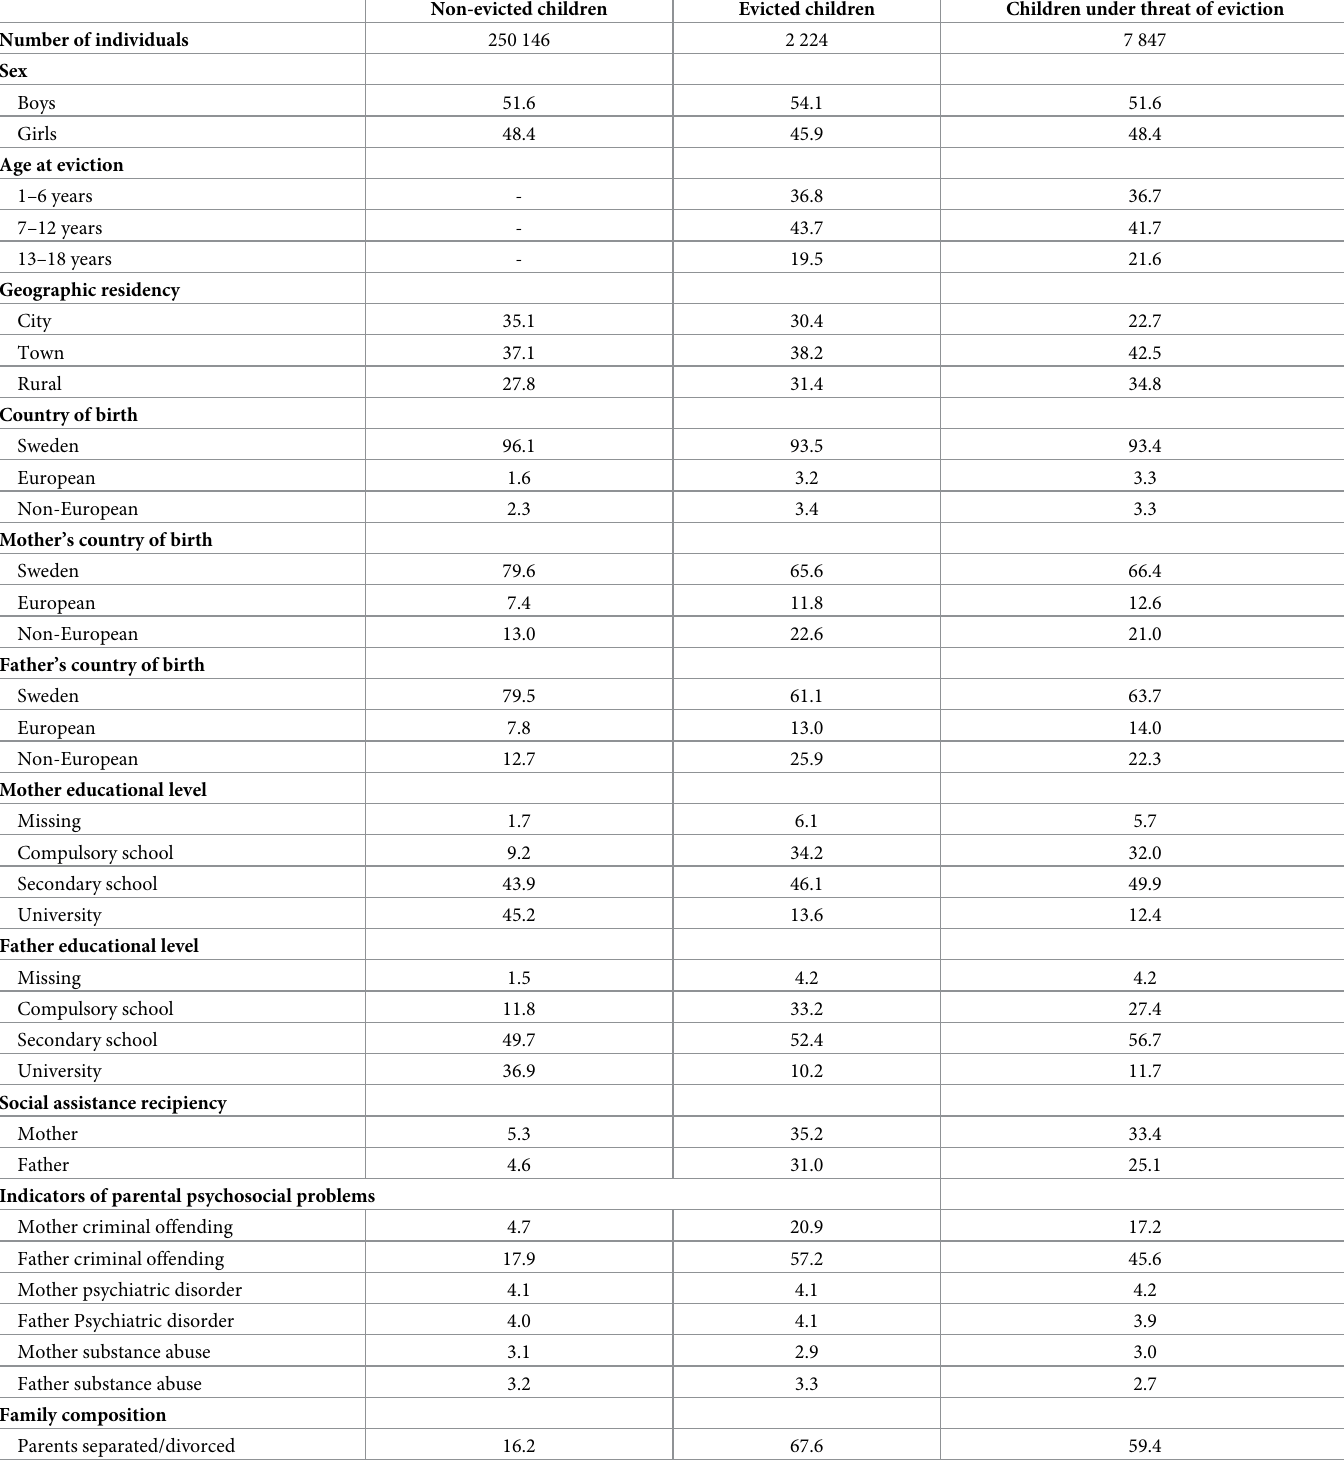
Table 2. Characteristics of the study